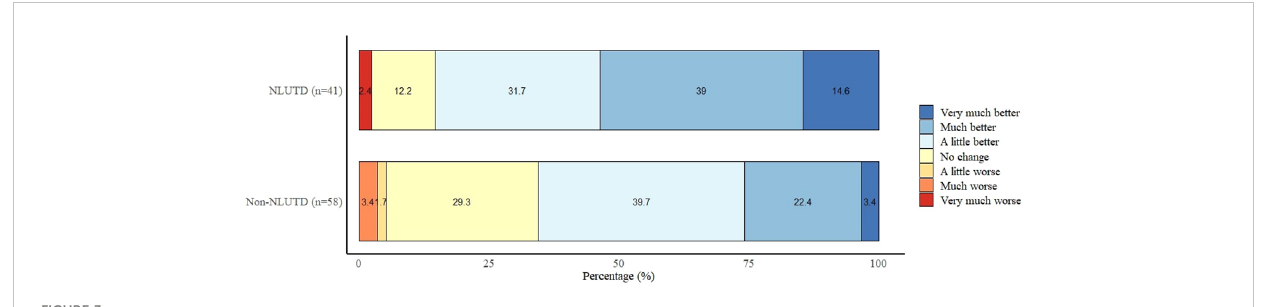
FIGURE 3 PGI-I outcomes of bladder irrigation with tap